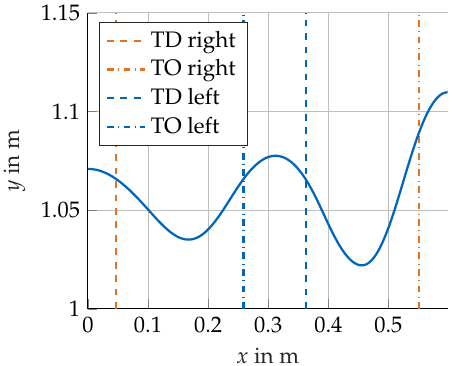
Figure 7. CoM trajectory of the modeled amputee during one GC in the HiL